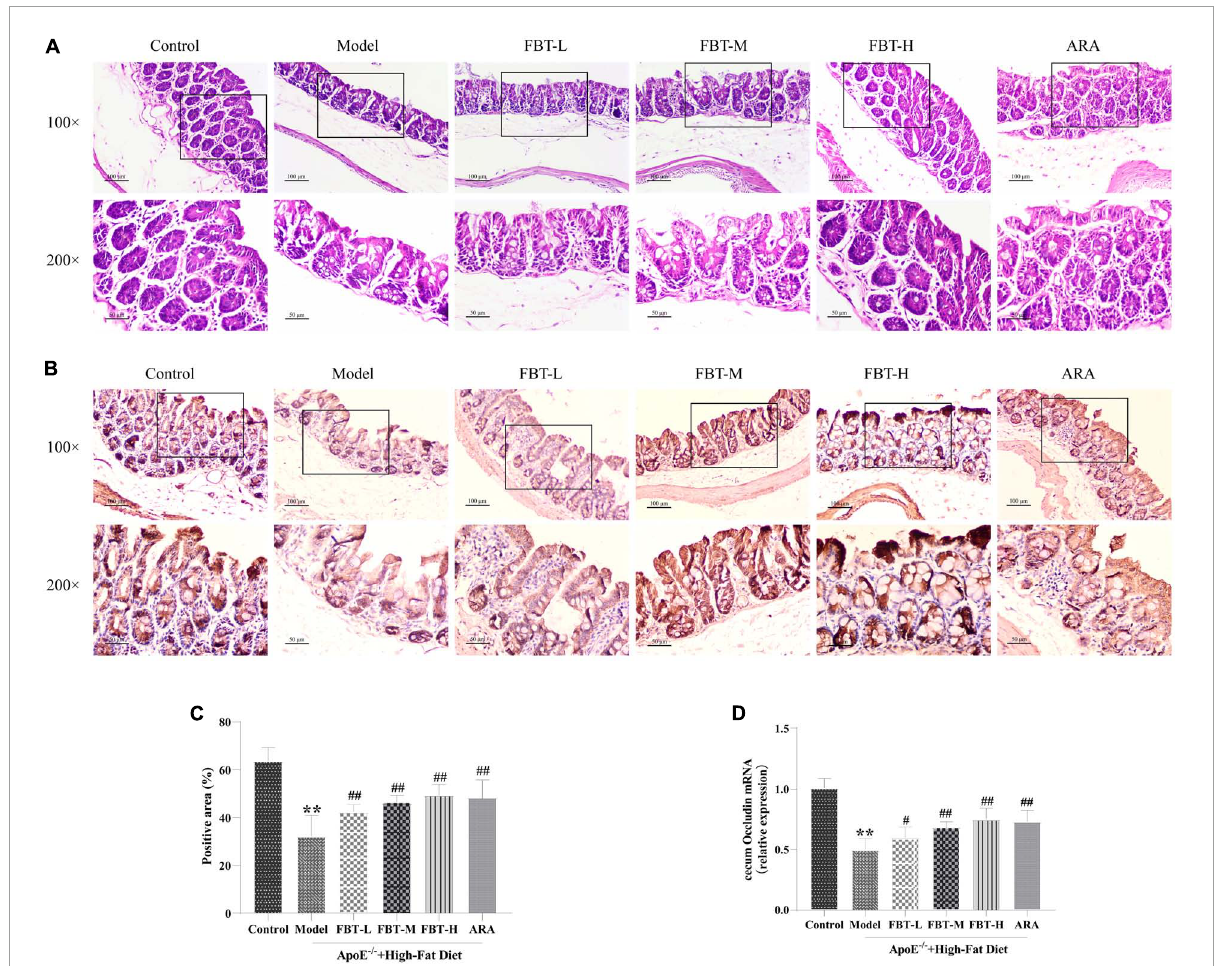
FIGURE7 Effects of FBT on cecal pathology and the cecal barrier of NAFLD mice. (A) HE staining indicated that FBT treatment ameliorated cecal mucosa in NAFLD mice (100 × and 200 × ); (B,C) immunostaining showed that the protein expression of Occludin in the cecum was increased after FBT treatment; (D) RT-qPCR showed that the gene expression of Occludin in the cecum was increased after FBT treatment. ** p < 0.01 vs. control group. n = 8. # p < 0.05, ## p < 0.01 vs. model